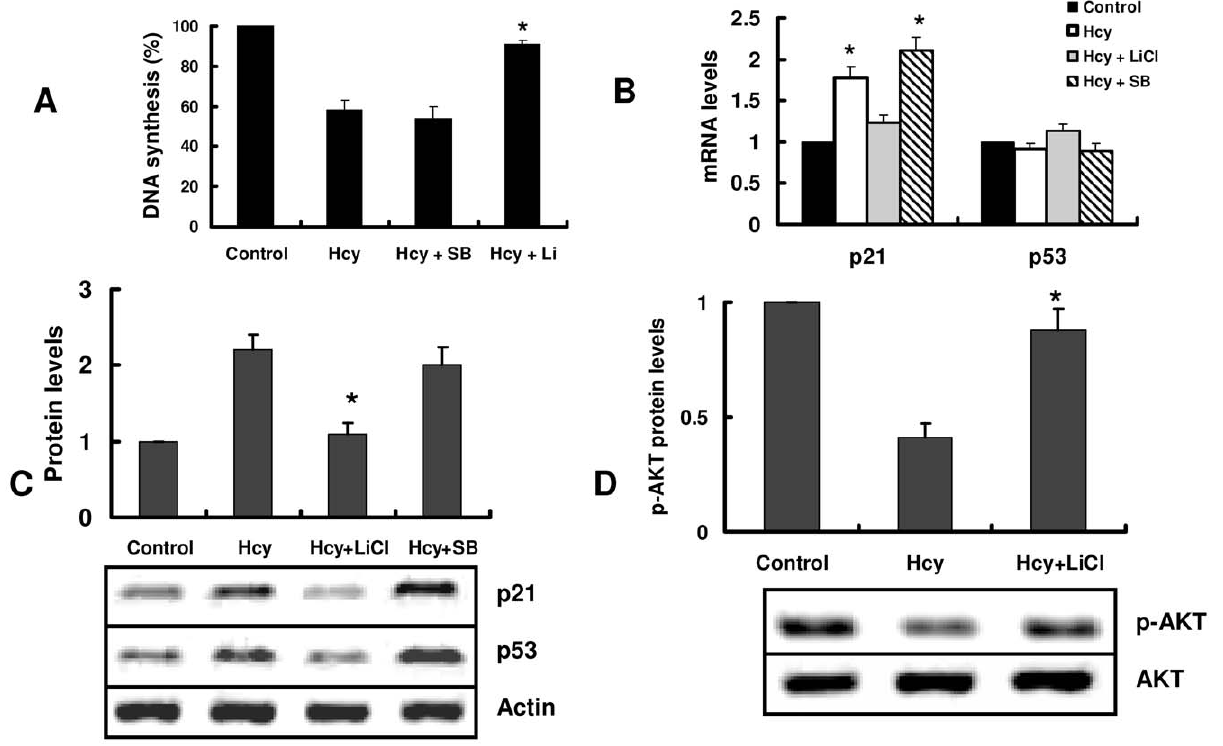
Figure 6. LiCl inhibits homocysteine-induced cell growth arrest through activation of Akt. Primary cultured hepatocytes were preincubated with SB216763 (10 m M) (SB) or LiCl (20 mM) before incubated with 1 mM homocysteine (Hcy). (A) After treatment with Hcy for 24 h, the cell proliferation was assessed by [ 3 H]-thymidine incorporation into DNA. (B) After treatment with Hcy for 8 h, the mRNA levels were detected by real- time PCR. All results are standardized to the levels of actin and are the means 6 SD of five experiments. (C) and (D) The protein levels were detected by Western blotting. The blot is representative of three independent experiments. The upper part shows quantification of immunoreactivity levels. The data are expressed as percent change from control. (C) * P , 0.05 versus control (without Hcy). (D) * P , 0.05 versus Hcy.